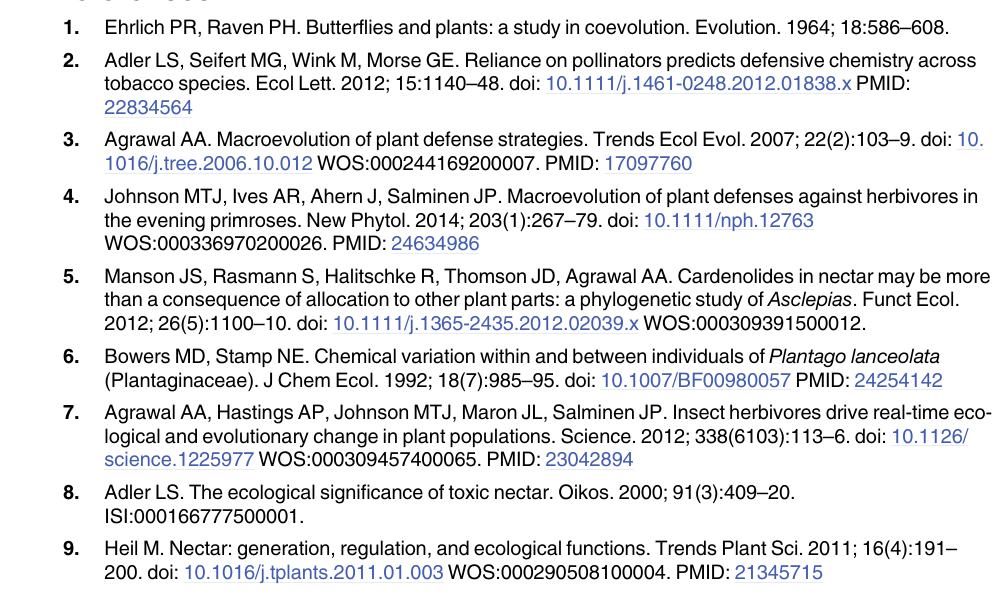
S1 Fig. Diagram of bee vial and feeder. Bees were housed individually in scintillation vials with ad libitum access to treatment solution. A 1.5 mL microcentrifuge tube was inserted into a 10 mm diameter hole in the vial's cap. The microcentrifuge tube was filled with the appropriate anabasine solution and plugged with a 10 mm long, 10 mm diameter wick of dental cotton. The vial also had four 1 mm diameter holes in the side for ventilation. S1 Data. Data used for statistical analyses. The first worksheet contains data used for the analysis of survival time. The second worksheet contains data used for analysis of probability of infection and parasite load. The third worksheet describes the variable names in the first two